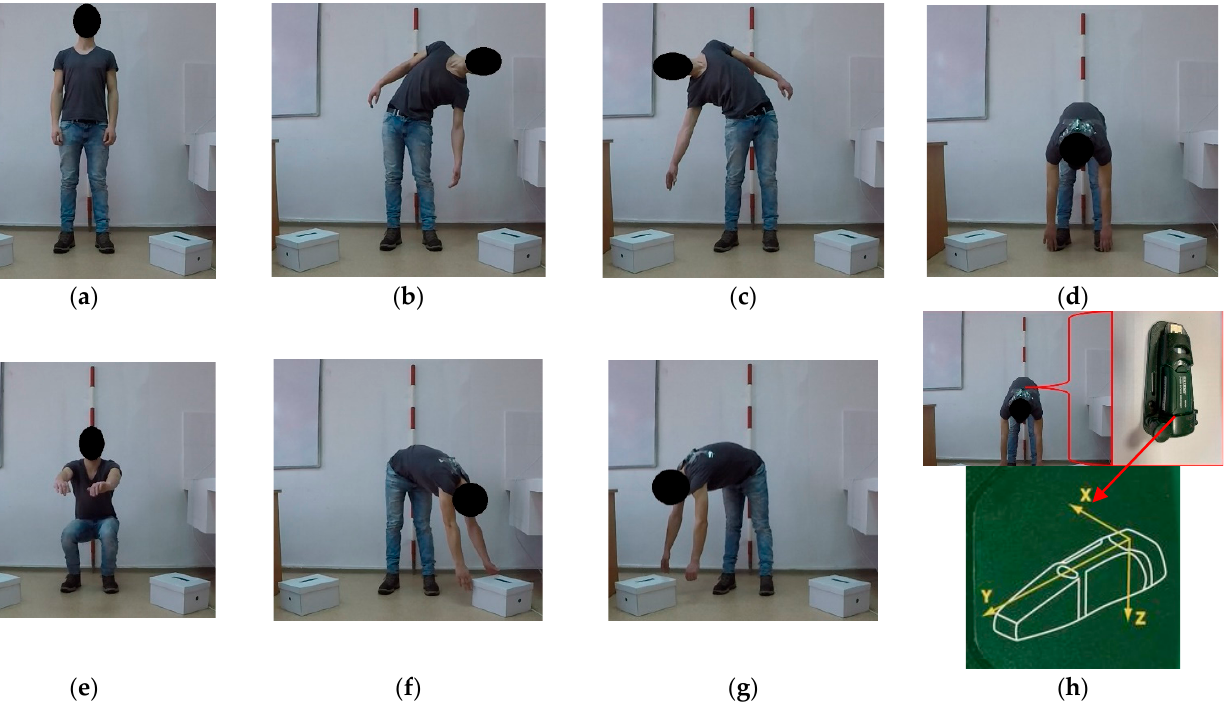
Figure 1. Description of the main postures of the back reached and maintained by the subject during the implementation of the movement protocol: ( a ) orthostatic posture maintained before each movement subprotocol and between the repetitions of a given subprotocol; ( b ) back bent to the left of the subject; ( c ) back bent to the right of the subject; ( d ) back bent forward; ( e ) knees bent, back straight; ( f ) back bent forward and twisted to the left; ( g ) back bent forward and twisted to the right; ( h ) placement of the datalogger, and the datalogger used to collect acceleration data, including axis orientation.